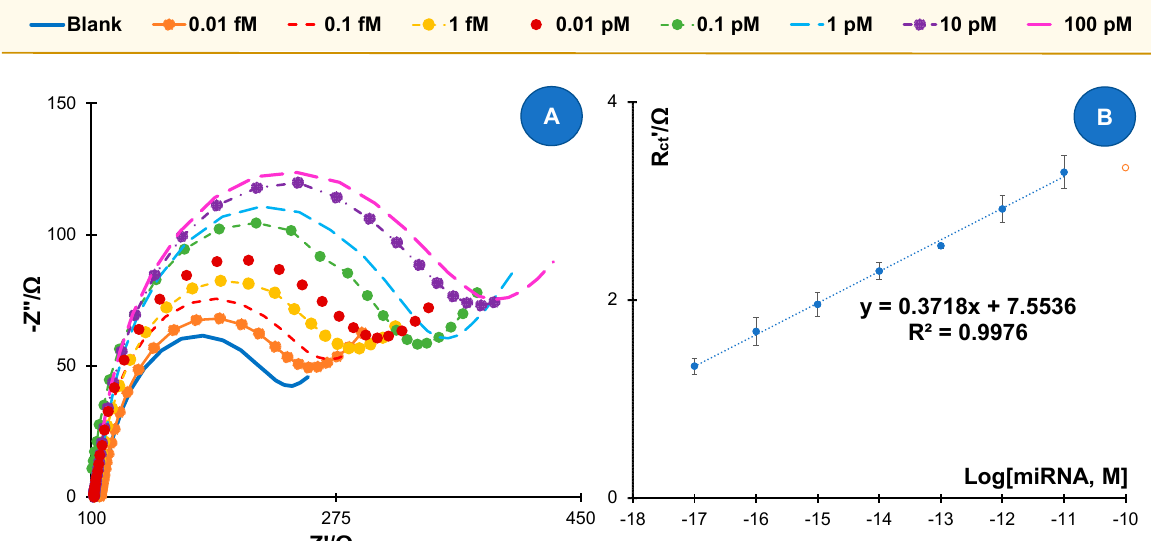
Figure 3. Calibration of the miRNA 21-5p biosensor in buffer background. ( A ) Nyquist plots; ( B ) and the corresponding calibration curve in 5.0 × 10 − 3 M [Fe(CN) 6 ] 3 − and 5.0 × 10 − 3 M [Fe(CN) 6 ] 4 − , in standard solutions prepared in buffer and using relative Rct data.